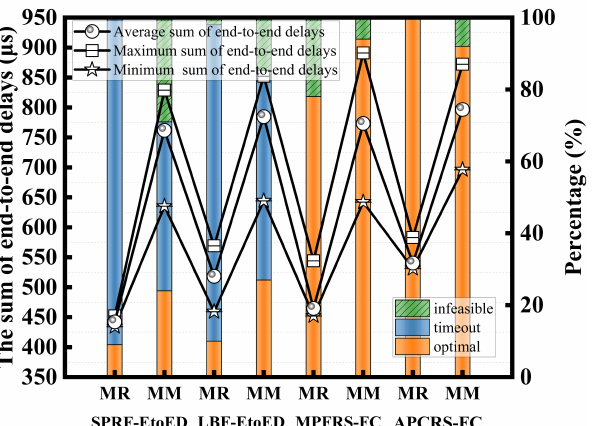
Figure 14. The sum of end-to-end delays of the SPRF-EtoED, LBF-EtoED, MPFRS-FC, and APCRS-FC for 100 test cases with 30 flows chosen from flow group 2, tested in different types of